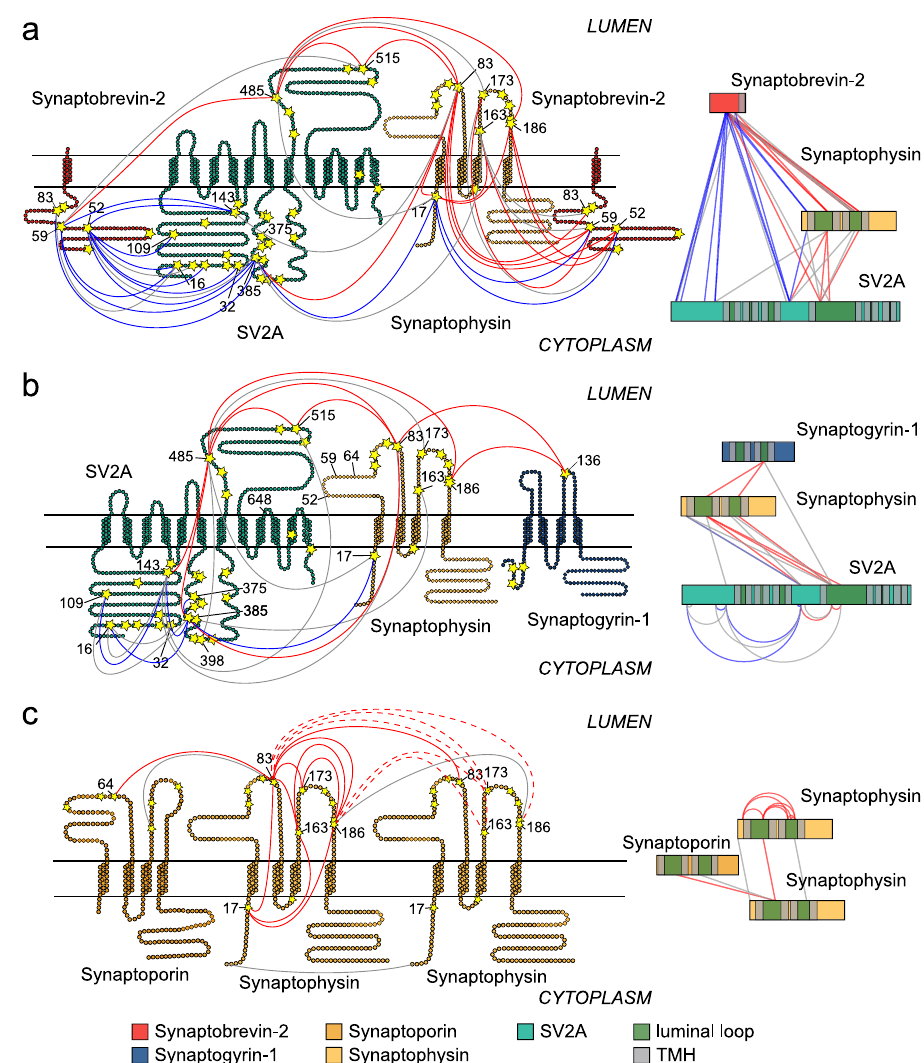
Fig. 4 Protein interactions identi fi ed in fl exible, luminal loops. Topology models are shown for Synaptobrevin-2 (red), Synaptoporin/Synaptophysin (yellow/orange), SV2A (green) and Synaptogyrin-1 (blue). Lysine residues are labelled with residues numbers. Cross-links are indicated by solid and dashed lines (across the membrane and luminal, red; cytosolic, blue; interactions identi fi ed in only one replicate, grey). Chemically labelled amino acid residues are indicated by stars. Interactions between individual proteins are shown in network plots (rhs). The length of the bars represents the protein length. The N-terminus is on the left and the C-terminus is on the right side of the bar. Transmembrane helices (TMH) and luminal loops are indicated on the protein bars. a Interactions and accessible amino acid residues of Synaptobrevin-2, SV2A and Synaptophysin. b Interactions and accessible amino acid residues of SV2A, Synaptophysin and Synaptogyrin-1. c Interactions and accessible amino acid residues of Synaptophysin and Synaptoporin. Cross-links that support oligomerisation of Synaptophysin are shown as dashed